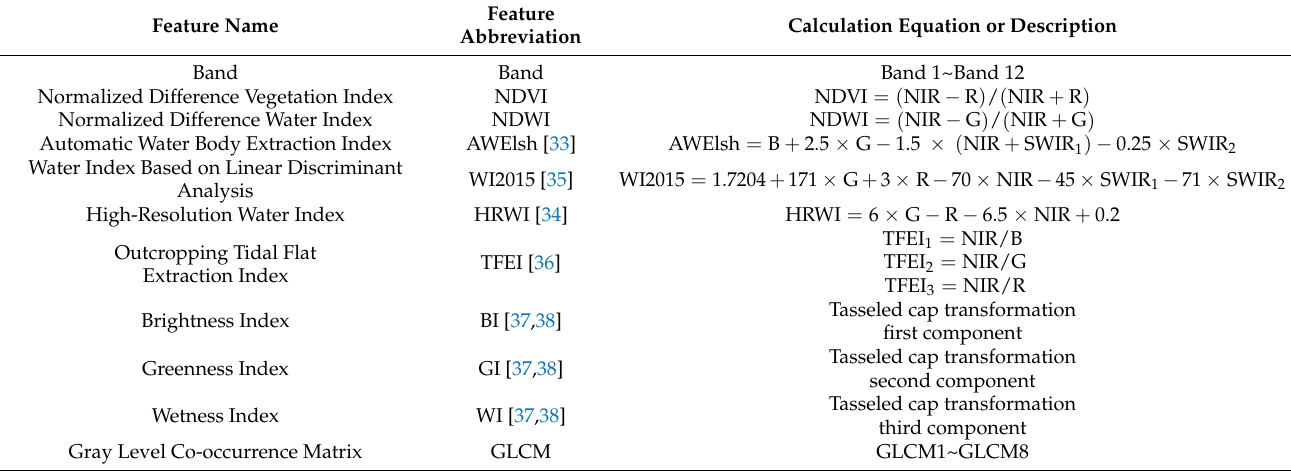
Table 1. Classification features and